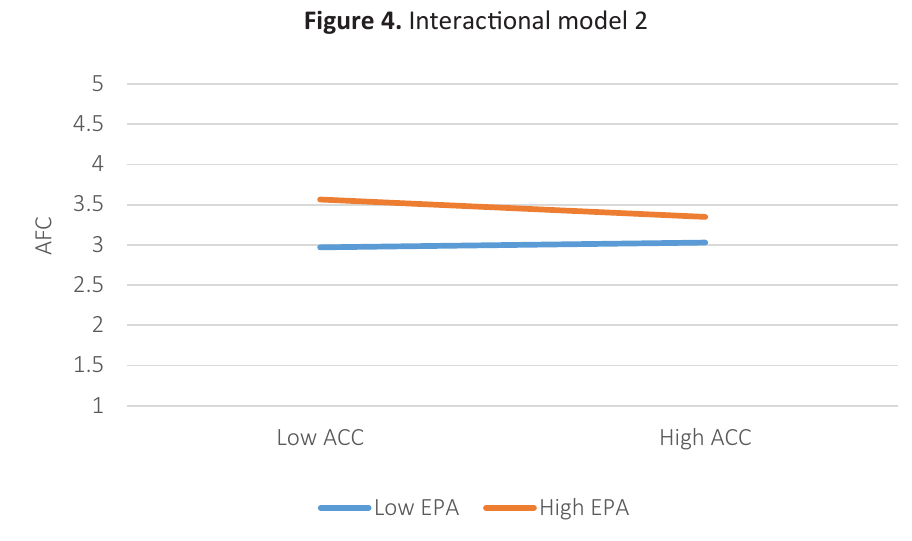
Figure 5. Interaction